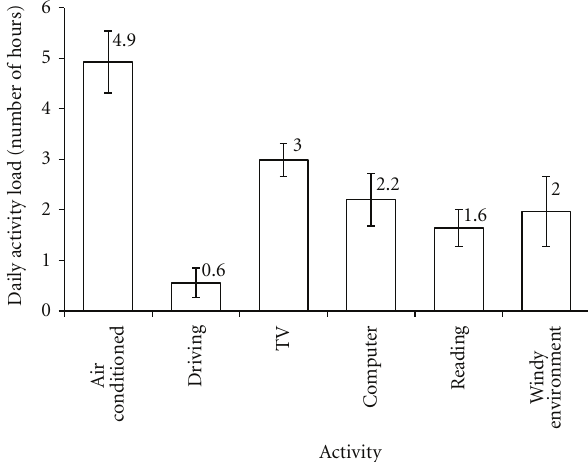
Figure 2: The average number of hours per day (of the 35 subjects) spent on each